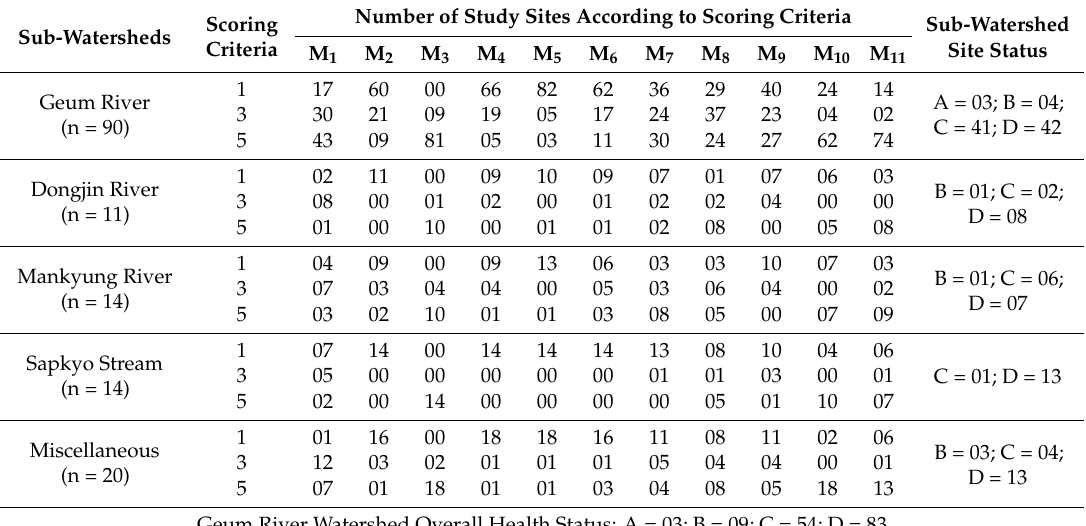
Table 6. Distribution of sites based on obtained mmIBI 11 values in Geum river